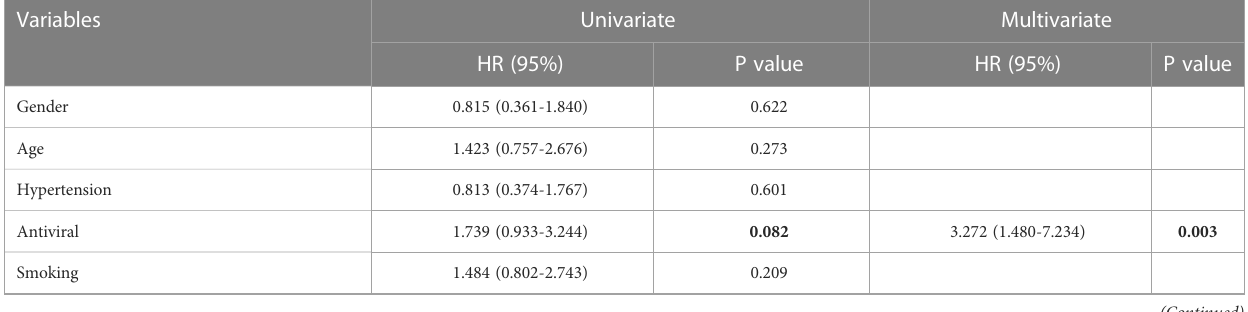
TABLE 3 Prognostic factors for OS by Cox proportional hazards regression